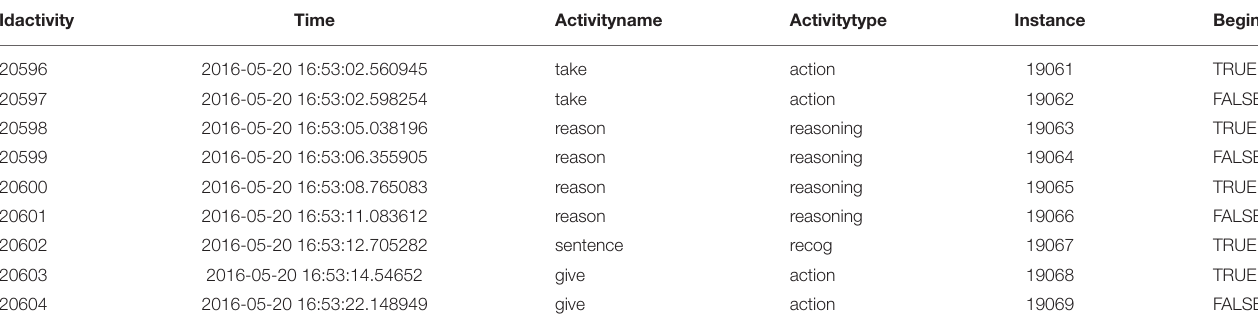
TABLE 5 | Principal SQL table of the ABM, regrouping all the events in the given period of execution of the human-robot interaction involving the complication-resolution scenario, where the iCub tries to grasp an object, fails, and asks the human for help. Idactivity